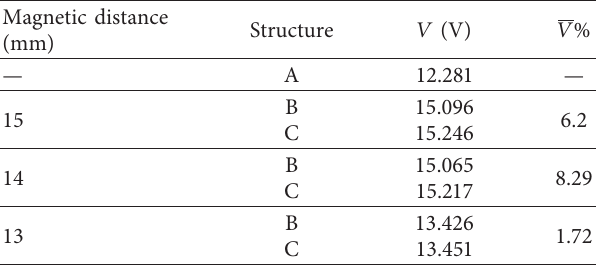
A is the conventional monostable piezoelectric cantilever beam; B indicates the bistable piezoelectric cantilever beam with the spring and the magnet; C indicates the bistable piezoelectric cantilever beam with the spring, the magnet, and the coil. V indicates the maximum output voltage; V % in- dicates the average growth rate of the output